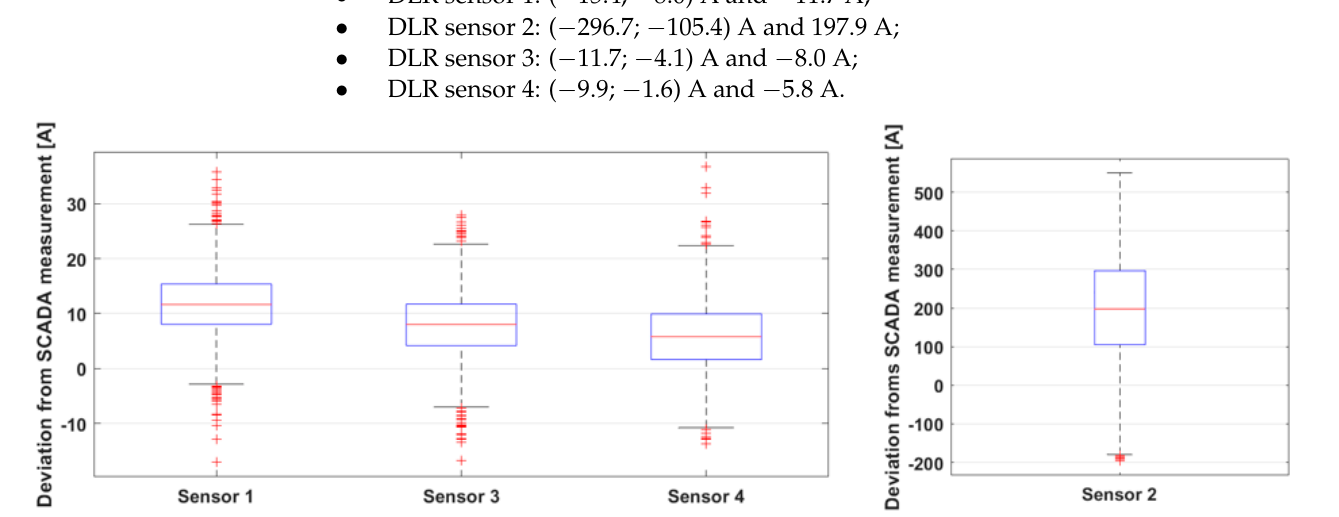
Figure 3. Boxplot diagrams of the four line monitoring sensors’ load measurements, April 2020.